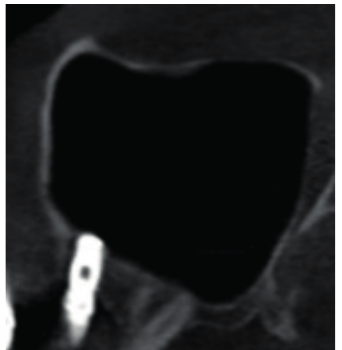
Figure 3. Relationship between dental implant and sinus